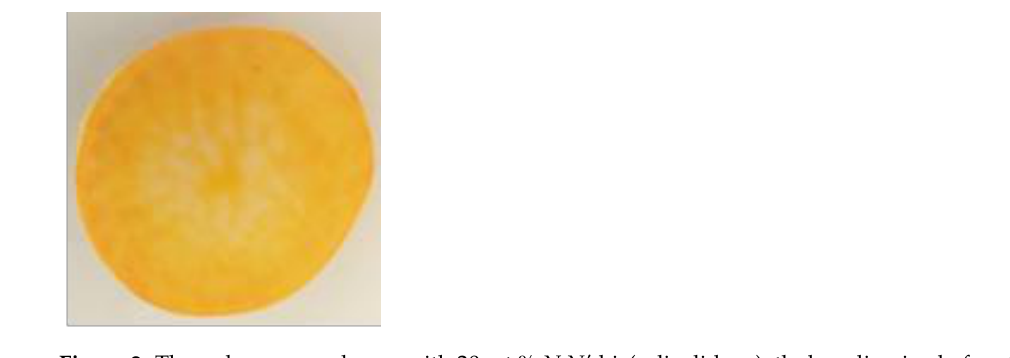
Figure 2. The polymer membrane with 20 wt.% N,N’ -bis(salicylidene)ethylenediamine before the sorption process.